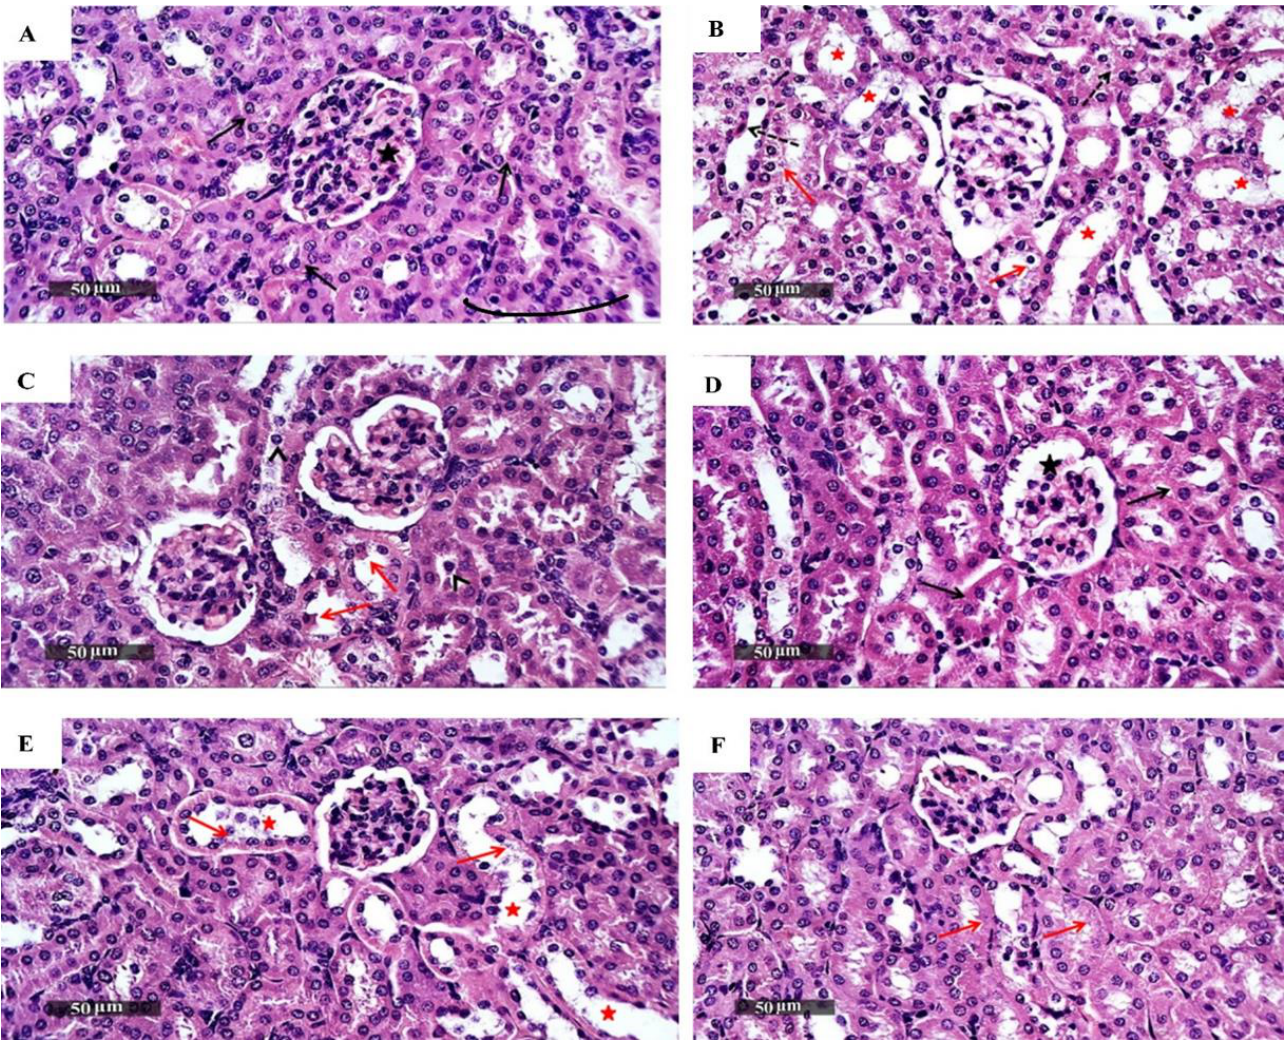
Figure 3. Photomicrographs of mice kidney sections, where renal tissue stained by H and E from ( A ), the normal control group, demonstrated normal histological features of the renal parenchyma with many intact renal corpuscles (star) and nephron segments with intact tubular epithelium (black arrow) and intact interstitial tissues and vasculatures. ( B ) Positive control treated with Dox, showing dilatation of the cortical tubular segments (red star) with tubular vacuolar degenerative changes (red arrow), loss of luminal border integrity, and occasional tubular epithelial necrotic cells records (dashed black arrow); ( C ) group treated with compound 3a, showing intact well-organized histological features of renal parenchyma with minimal records of sporadic tubular epithelial changes (red arrow); ( D ) group treated with compound 4b, with almost intact histological features of renal parenchyma; ( E ) group treated with compound 4c, where most of the tubular segments showed almost intact well-organized morphological features (as in ( A )), and ( F ) negative control group that received DMSO, which showed almost intact histological features of renal parenchyma with minimal records of tubular degeneration (red arrow). [scale bars 50 µm].